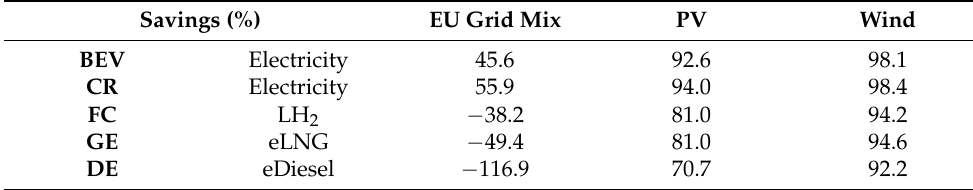
Table 7. Perceptual GHG saving for the selected fuel–powertrains